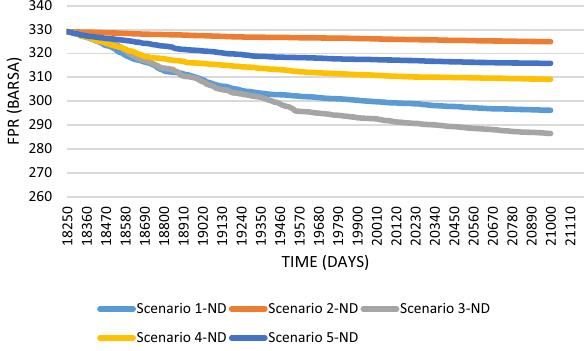
Fig. 7 Field reservoir pressure drop trend in five natural depletion